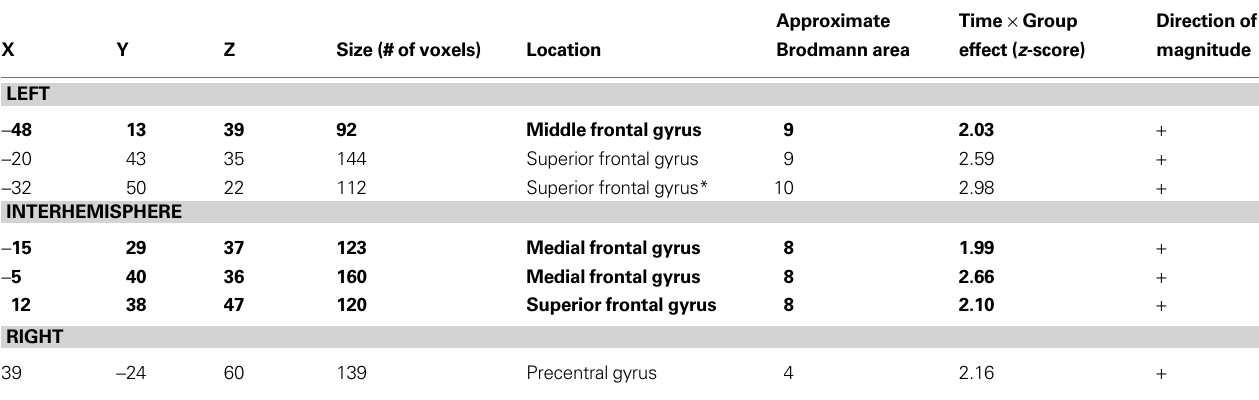
Table 5 | SUSTAINED: Seven brain regions showing a signifi cant sustained signal group effect, such that TS adolescent group activity was greater than the unaffected adolescent group activity (sphericity-corrected p -values < 0.05).